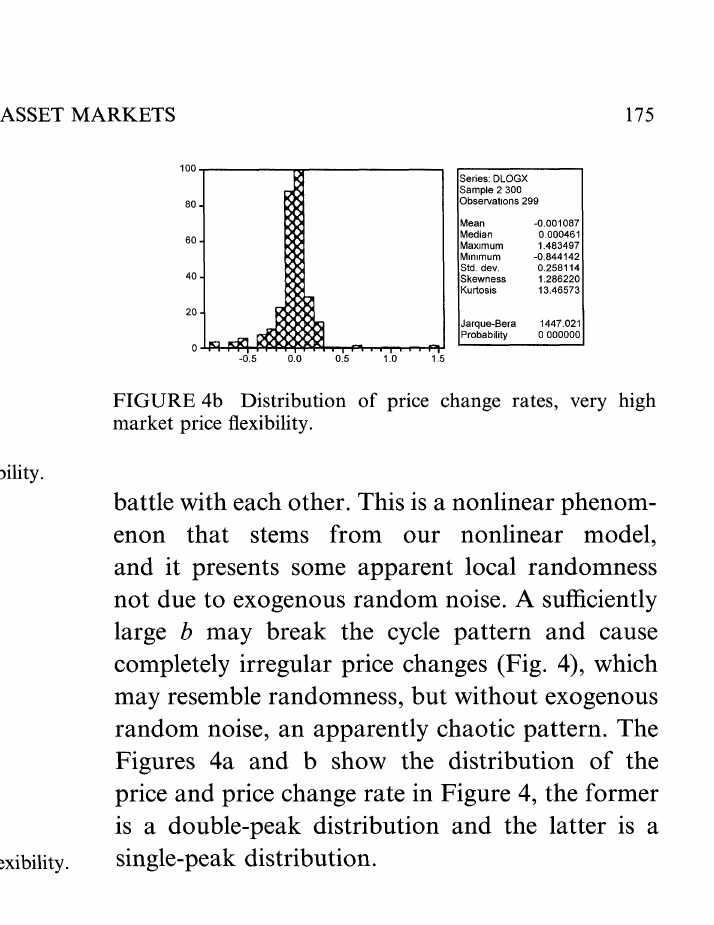
FIGURE 2 Price dynamics, moderate market price flexibility.